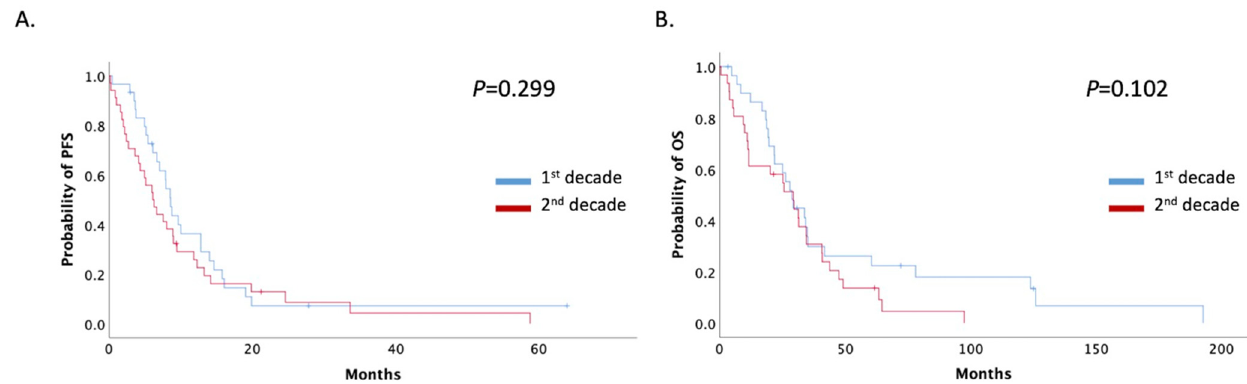
Figure 3. ( A ) Patients with recurrent or de novo metastatic disease mPFS stratified by decade of treatment (1st decade: 1999–2009, 2nd decade: 2009–2019); ( B ) Patients with recurrent or de novo metastatic disease mOS stratified by decade of treatment (1st decade: 1999–2009, 2nd decade: